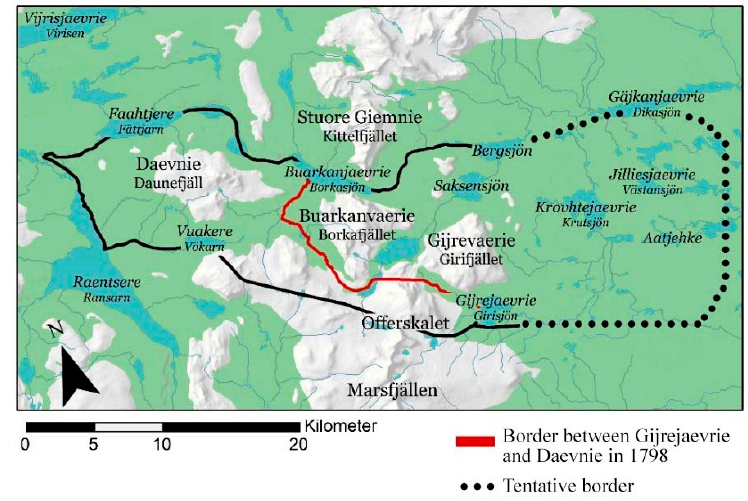
Figure 2. Gijrejaevrie taxation land.